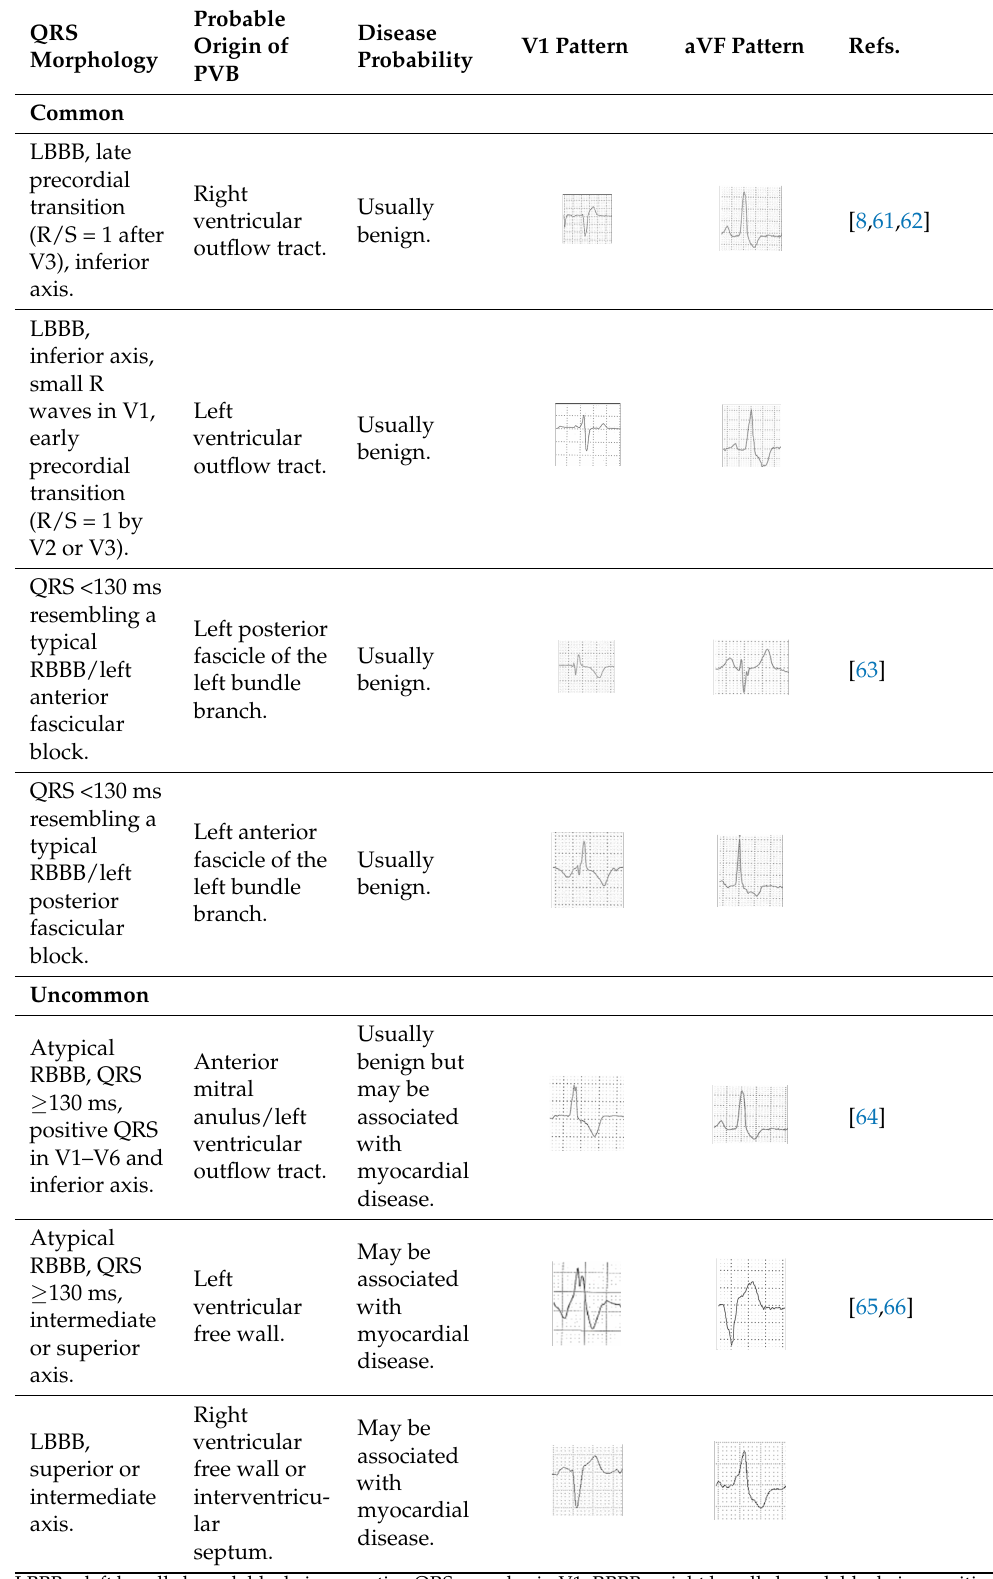
Table 1. Classification of PVBs morphology according to the probability of an underlying pathological myocardial